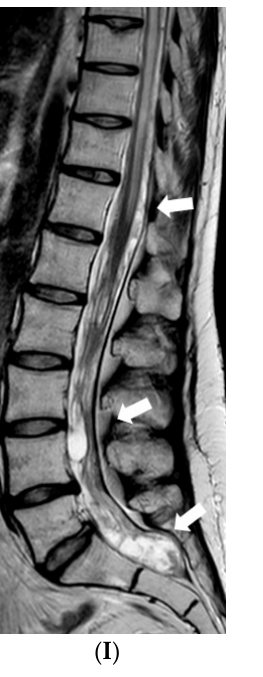
Figure 6. Follow-up MRI of the brain and spinal cord 9 years after the onset of symptoms (November 2020): ( A ) Axial T2W/FLAIR, ( B , C ) and ( D ) sagittal T1W post-contrast images demonstrate residual non-enhancing cystic lesions in basal cisterns and posterior fossa surrounding brainstem and cerebellum. ( D ) Sagittal T1W post-contrast image shows diffuse atrophy of the cerebellum. ( E , G , I ) Sagittal T2W and ( F , H , J ) T1W post-contrast images of ( E , F ) cervical, ( G , H ) thoracic, and ( I , J ) lumbar spinal cord reveal diffuse intradural extramedullary mixed cystic and solid lesions that show medium contrast enhancement and slight compression of spinal cord at various levels.